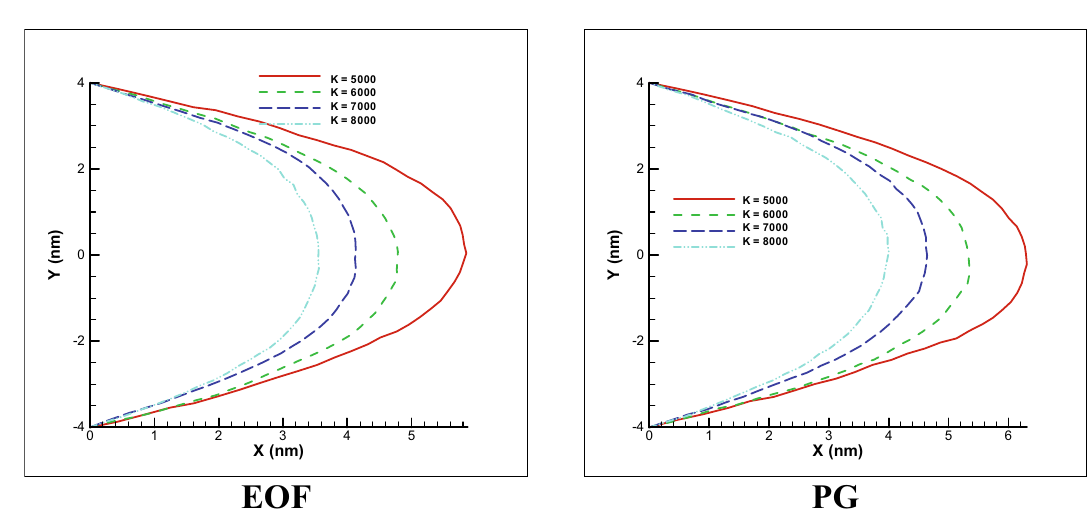
Figure 6. Restricted movement of the polymer chain in a simple channel under the influence of a constant external force (PG of 0.01 DPD unite) and electroosmotic force (EOF, Table 1) with spring coefficient of 8000 between the beads over number of steps (N.S) and time step for n = 50.